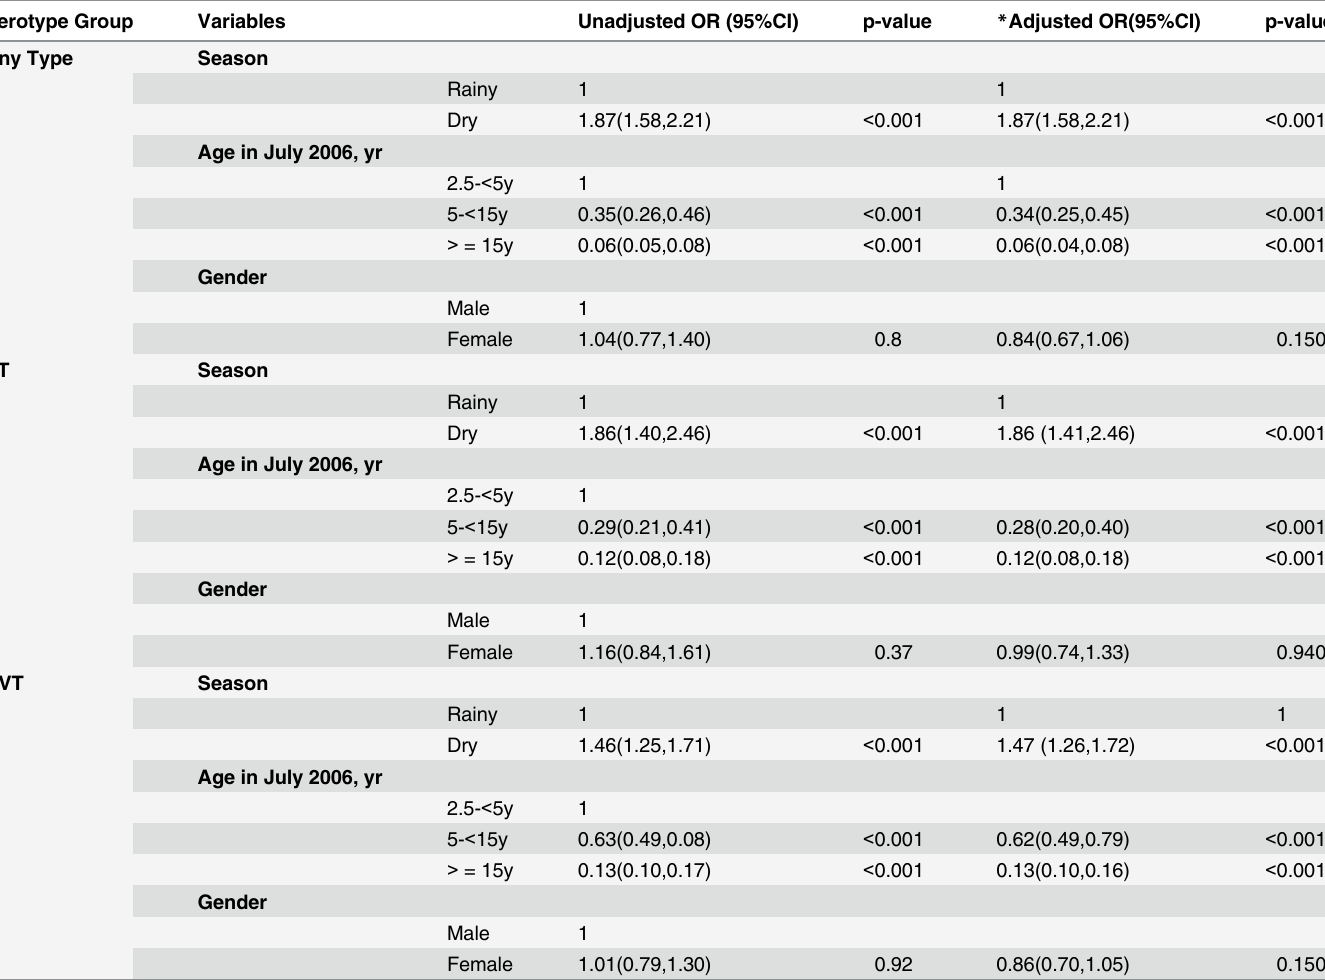
Table 3. Adjusted analysis of VT, NVT and Any Type pneumococcal carriage. Serotype